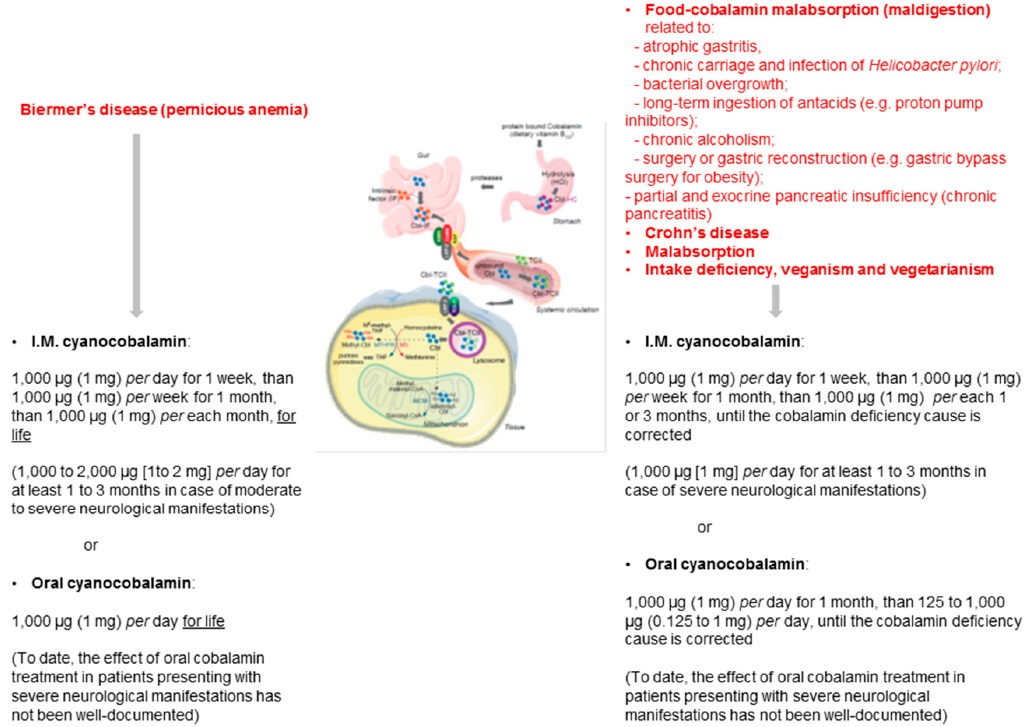
Figure 3. Pragmatic clinical approach to oral vitamin B12 treatment in patients with vitamin B12 deficiency related to gastrointestinal disorders [14,40].